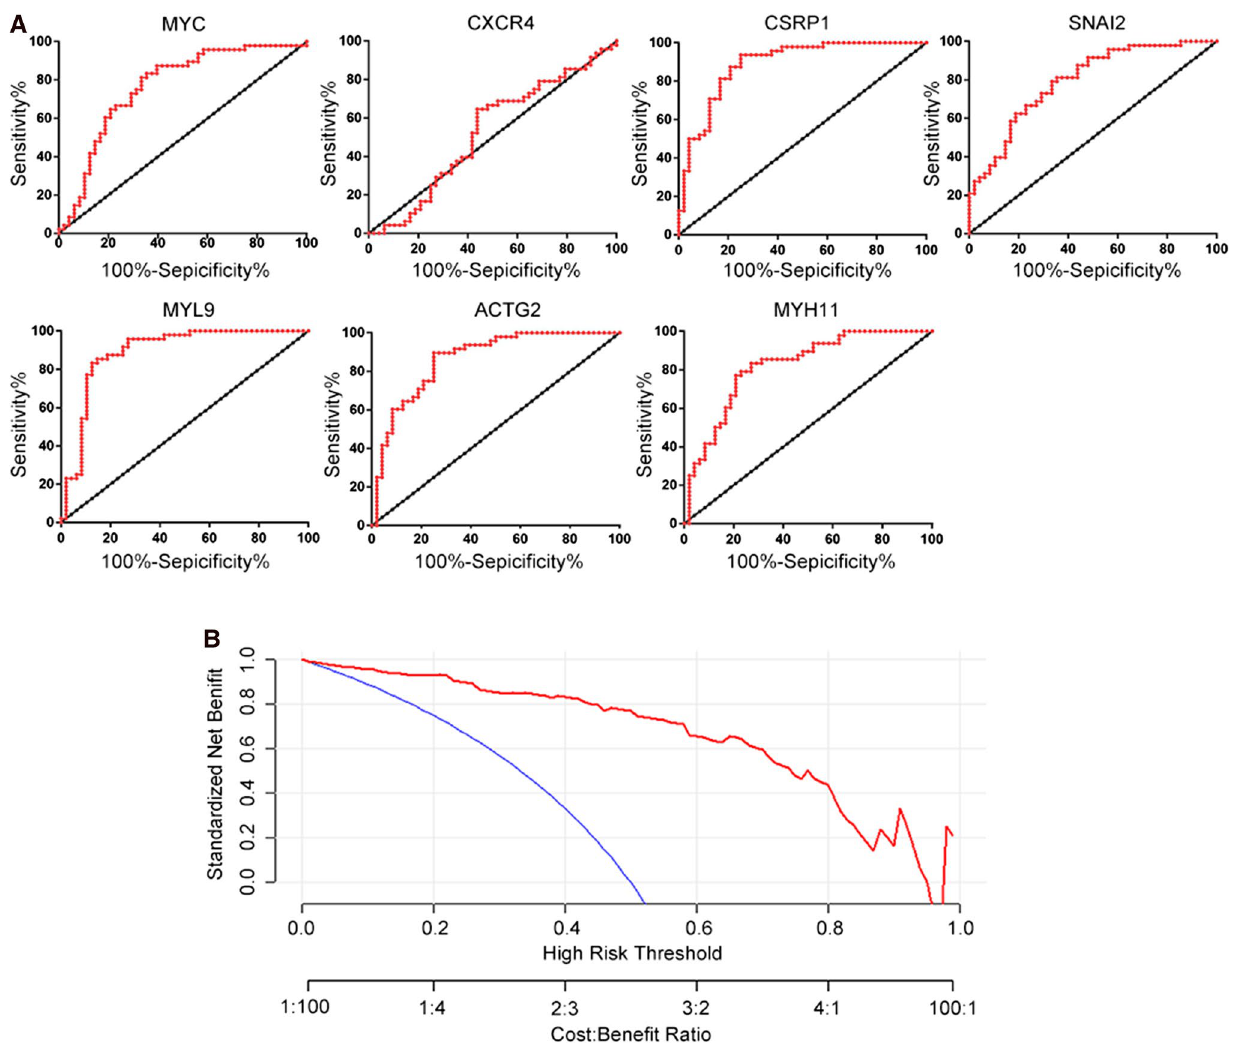
Fig. 4 The diagnostic model of hub genes was constructed. A The ROC curve of hub genes was constructed in predicting PCa. B The DCA of 7 hub genes was draw in predicting PCa Table 2 The diagnostic value Id P of hub genes in PCa